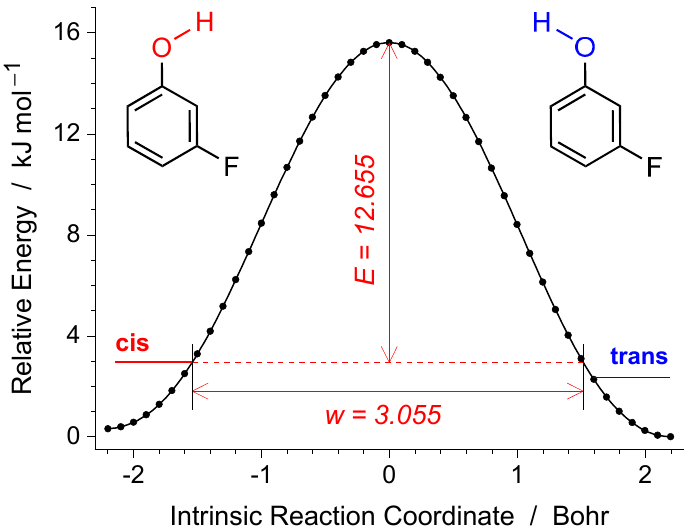
Figure 5. Intrinsic reaction coordinate (IRC) for the OH rotamerization in m FP computed at the B3LYP/6-31++G(d,p) level of theory in Cartesian (non-mass-weighted) coordinates. The vertical arrow ( E = 12.655 kJ mol − 1 ) designates the computed ZPE-corrected energy of the transition state with respect to the reactant ( cis , given in red). The horizontal arrow designates the width ( w = 3.055 Bohr) of the barrier at the ZPE level of the reactant. The relative zero energy corresponds to the product ( trans , given in blue).